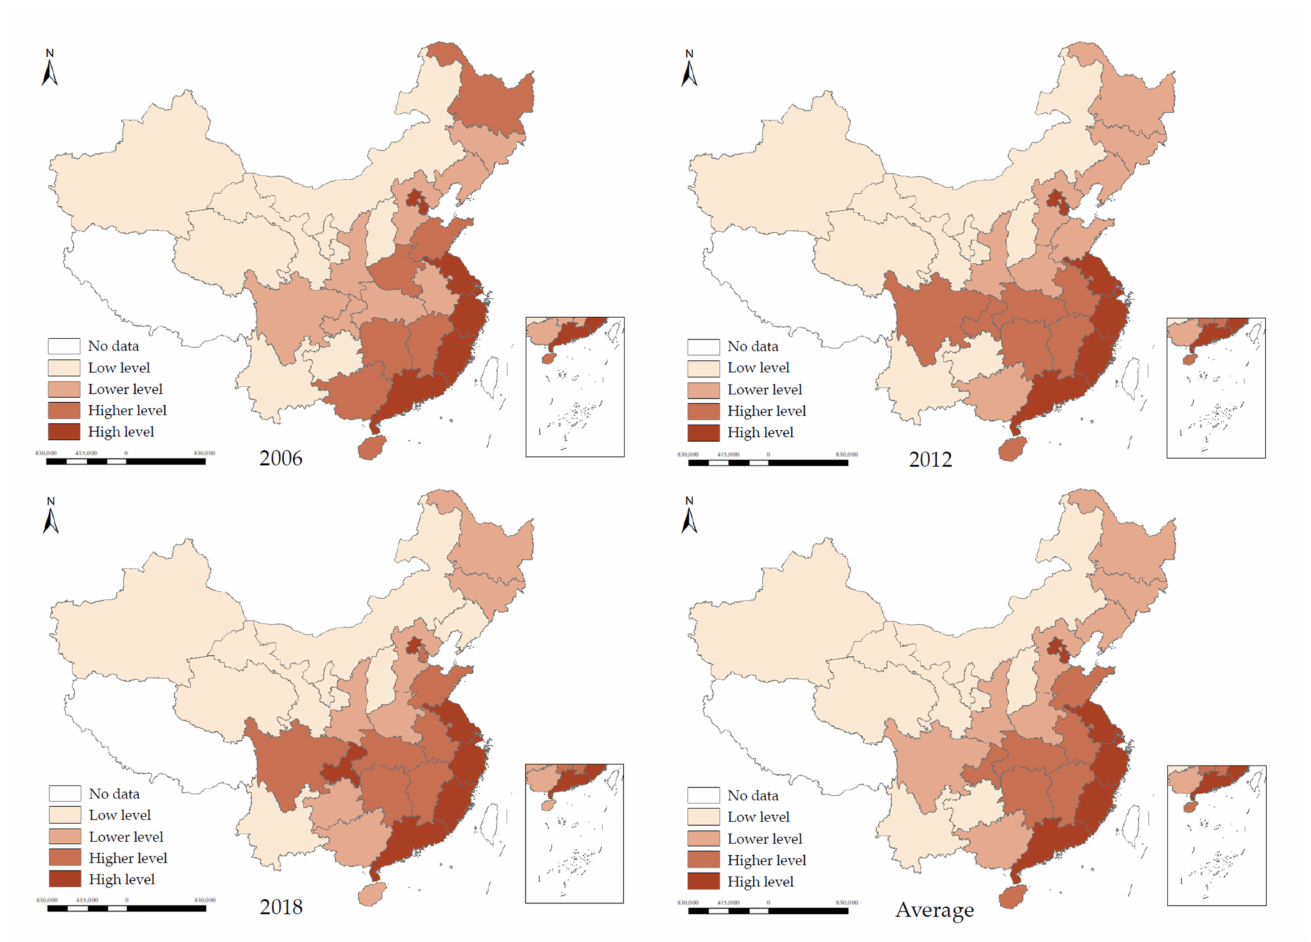
Figure 4. Classification of carbon emission efficiency in China in 2006, 2012, 2018 and annual